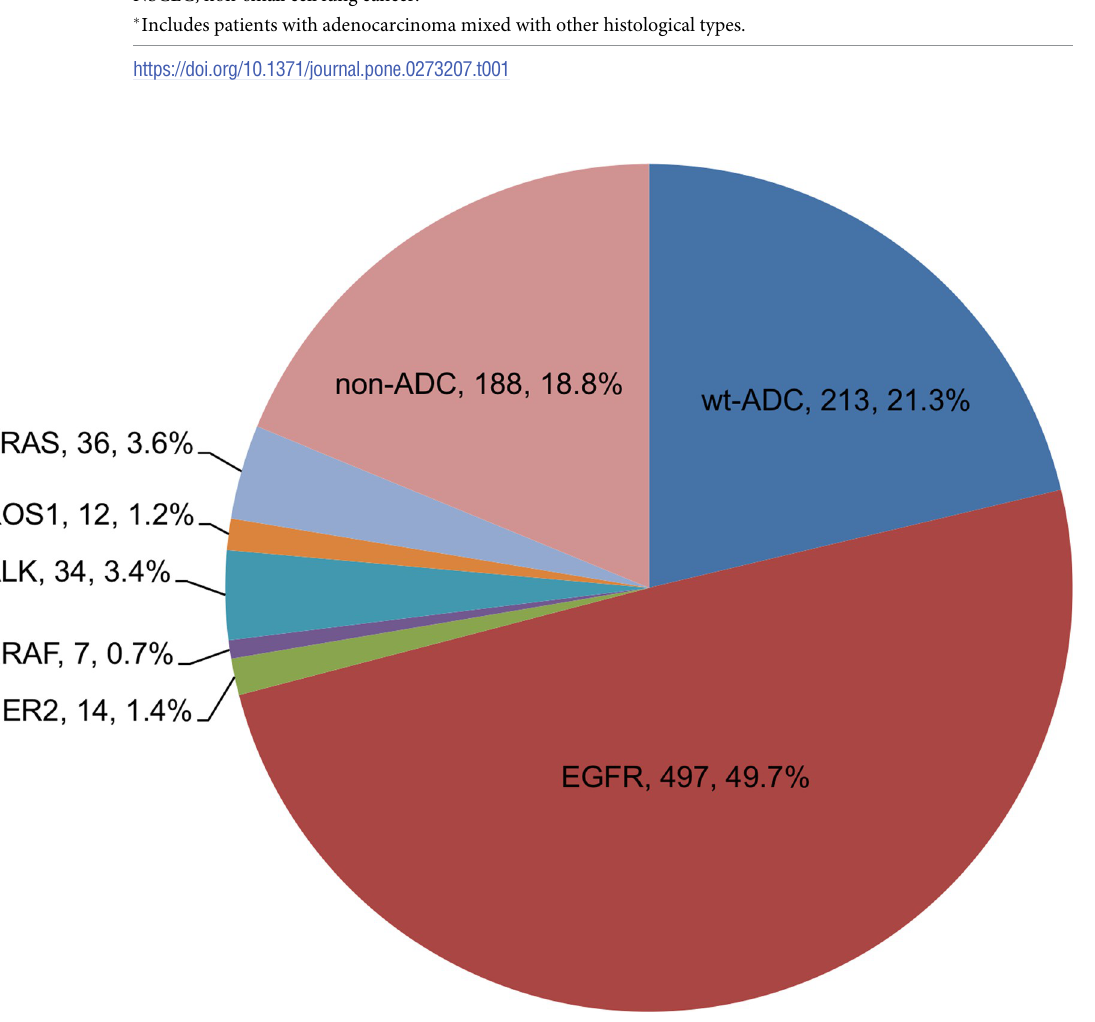
PLOS ONE | https://doi.org/10.1371/journal.pone.0273207 August 18,